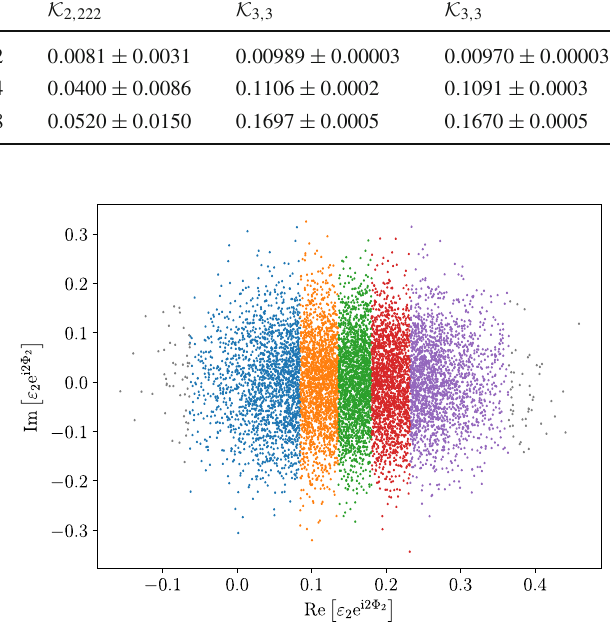
Fig. 9 Scatter plot of the initial complex eccentricity ε 2 e 2i (cid:4) 2 ≡ ε 2 , c + i ε 2 , s for 10 4 events at b = 6 fm. The bins are the same as in Fig.